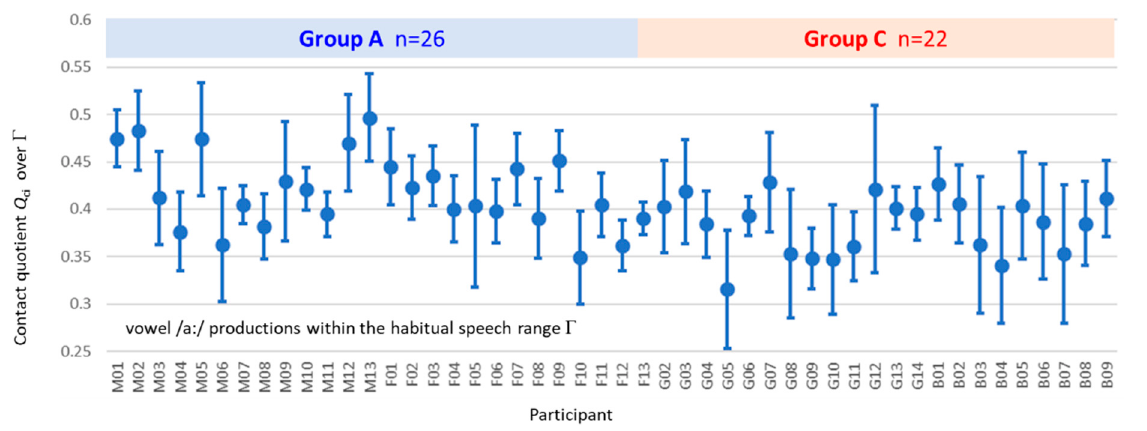
Figure 8. The descriptive statistics of the EGG contact quotient Q ci over Γ for group A (adults) and group C (children), taken from sustained /a:/ productions within each participant’s Γ only. Filled circles are the means, vertical bars are the standard deviations. (Previously unpublished data, collected for [18].)